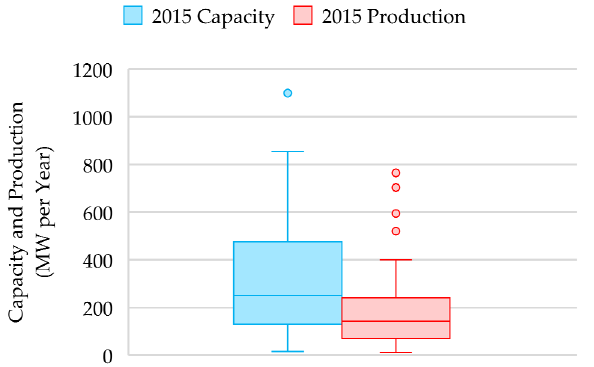
Figure 4. Box-and-whisker plot for the capacity and real production of 49 PV module manufacturers in 2015 [29].